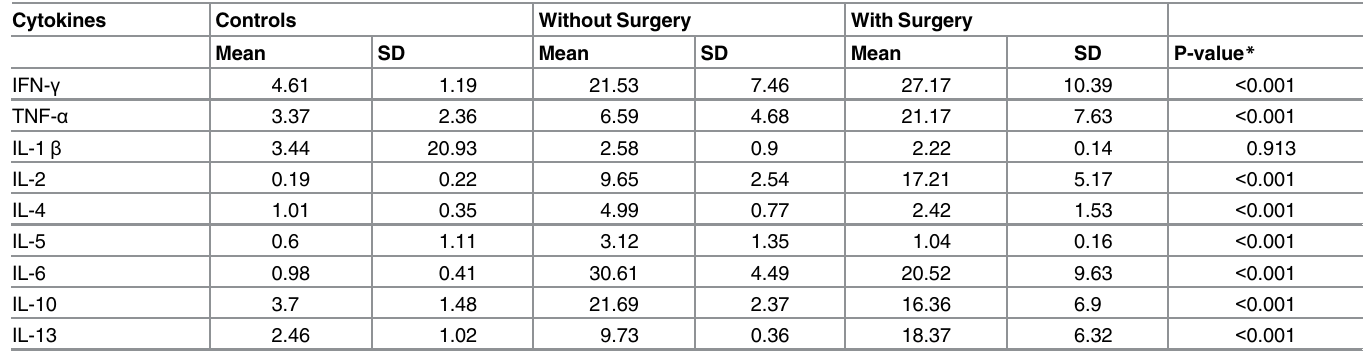
Table 2. Description of median and range of cytokines (IFN- γ , TNF- α , IL-1B, IL-2, IL-4, IL-5, IL-6, IL-10 and IL-13) level/ μ l in different study groups.